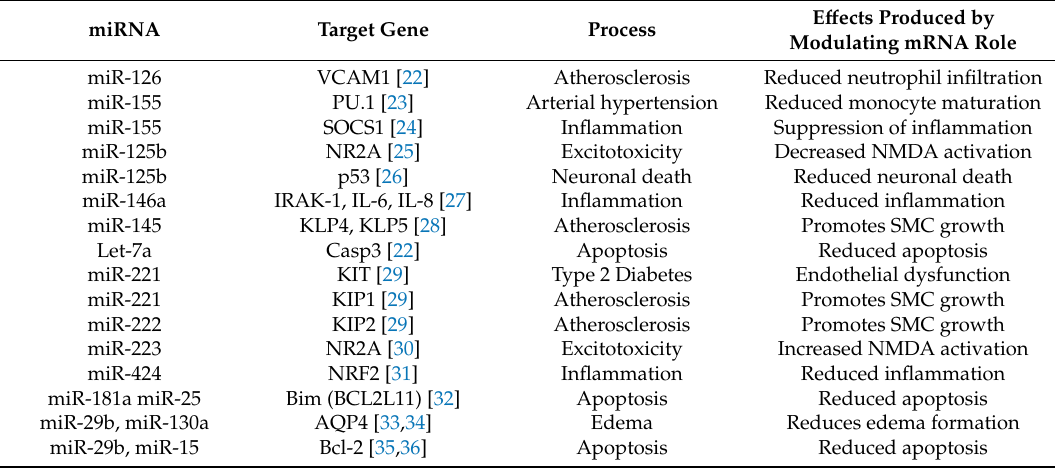
Table 1. The role of miRNAs to modulate specific genes and mRNA of various risk factors of ischemic